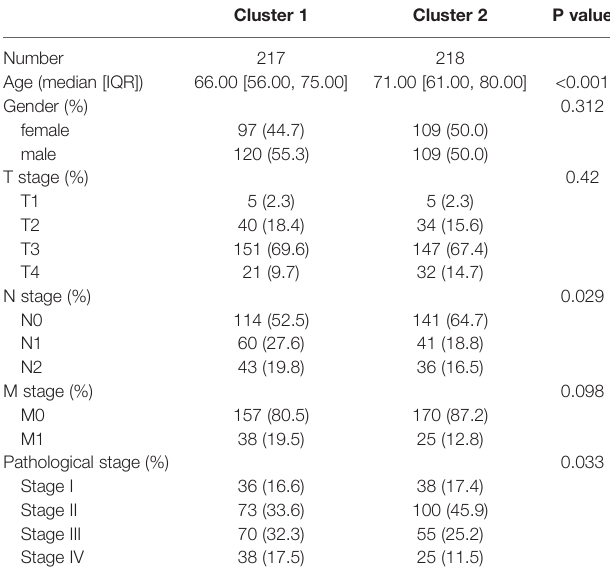
TABLE 1 | Clinical features of two